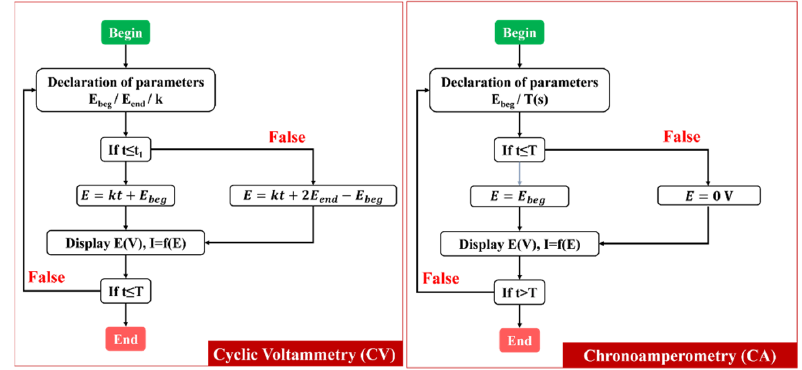
Figure 4. CV and CA processes developed with LabVIEW.